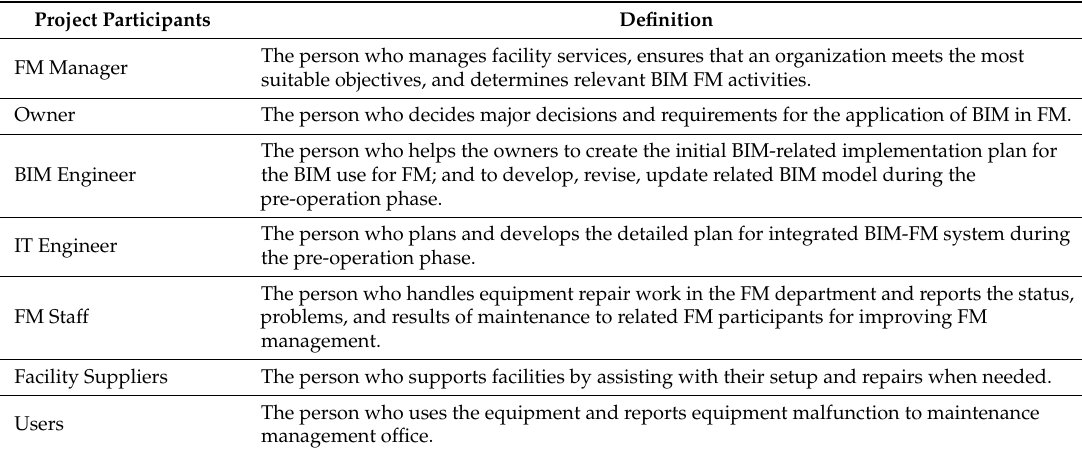
Table 1. The detailed required roles for BIM model usage for FM.